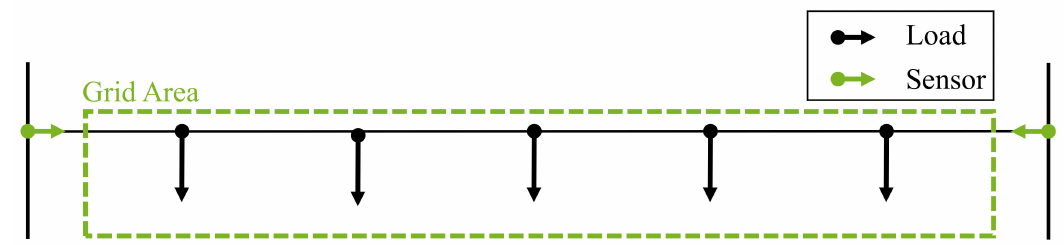
Figure 2. Example of a grid area defined by two